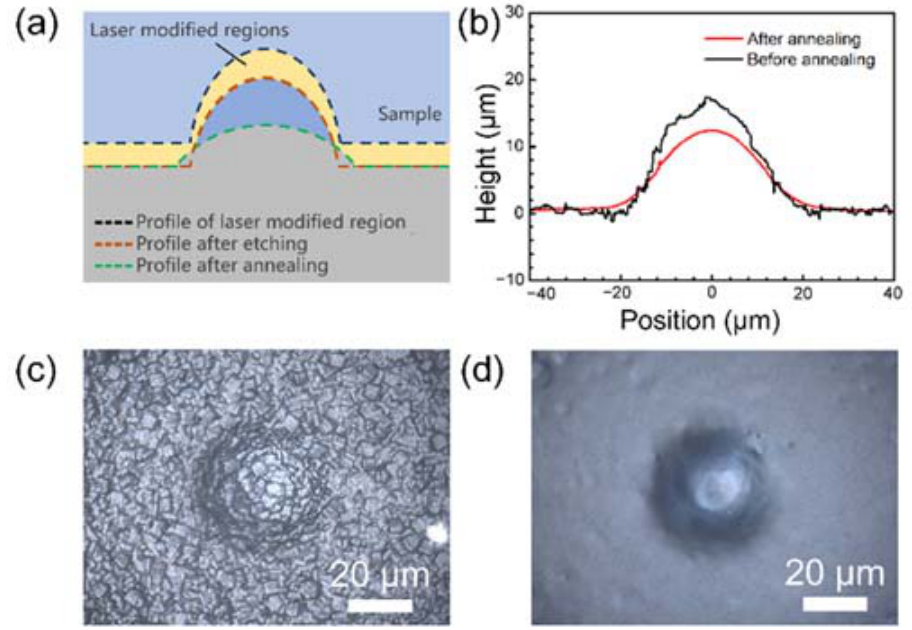
Figure 2. Evolution of microlens morphology during preparation. ( a , b ) Schematic diagram and experimental results. ( c , d ) Comparison of surface morphology before and after secondary annealing.